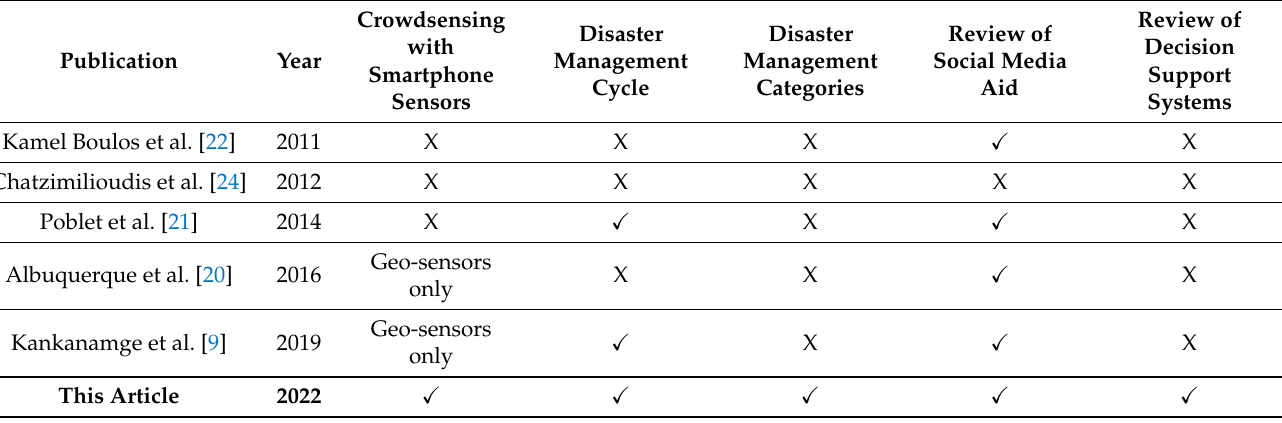
Table 1. Gap Analysis of Previous Literature